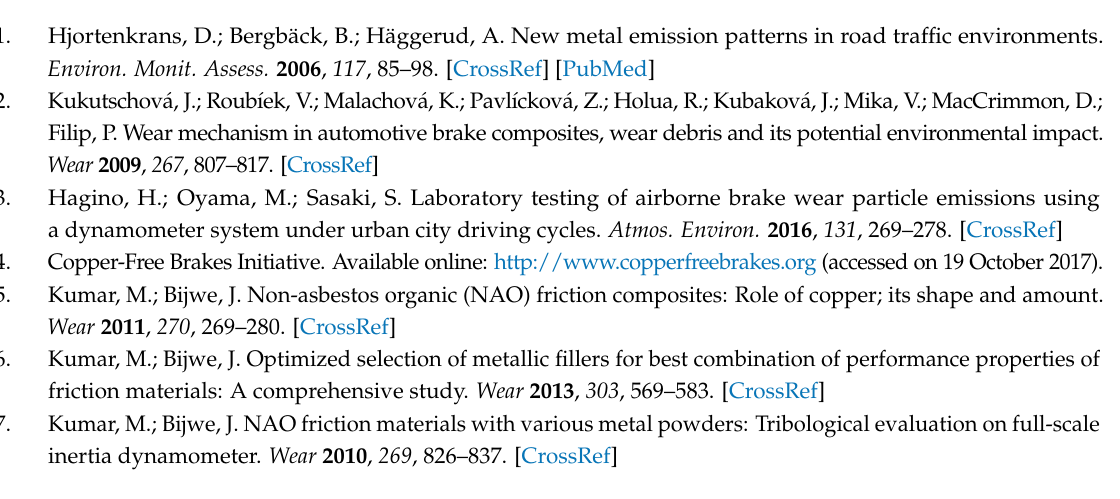
s1, Figure S1: EDS spectrums of the worn surfaces of the brake composites: (a) C 10 L 5 ; (b) C 5 L 10 ; (c) C 15 L 0 ; (d) C 0 L 15